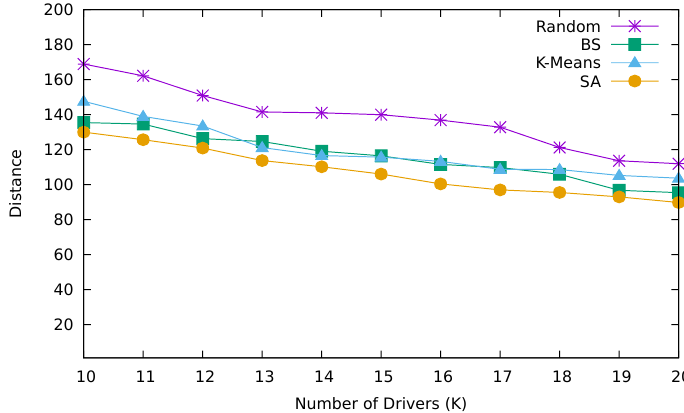
Figure 7. Distances over various number of remote driving